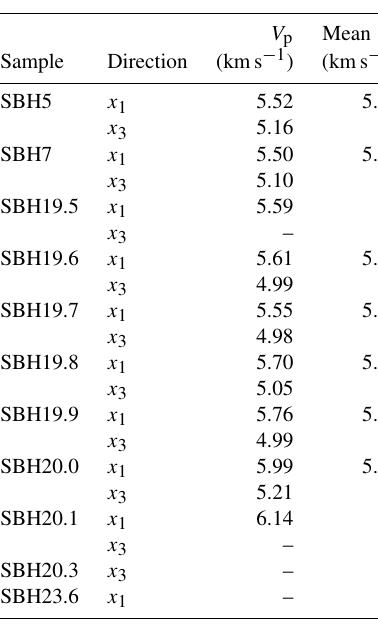
Table 2. Summary of density, porosity, elastic properties and anisotropy, and permeability obtained from laboratory measurements. Labora- tory velocities measured at 30MPa confining pressure and permeability measured at 10MPa effective